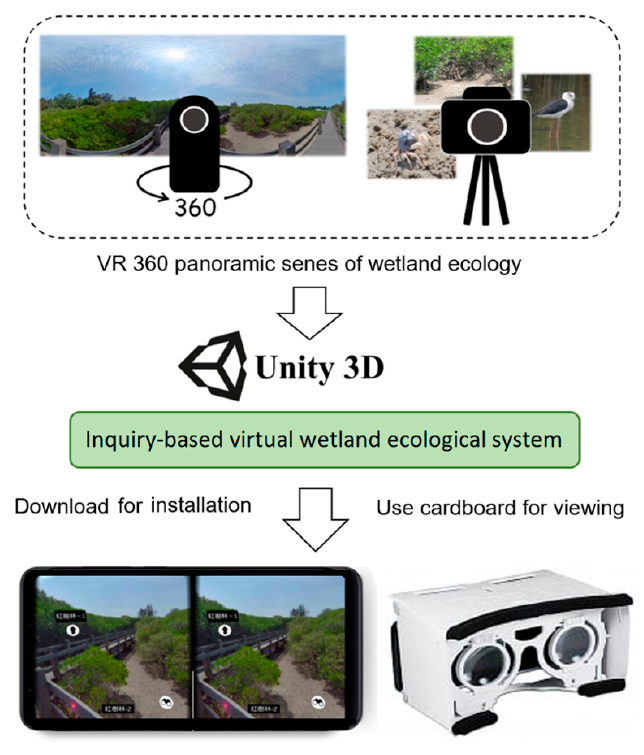
Figure 1. The virtual wetland ecological system for inquiry-based learning.